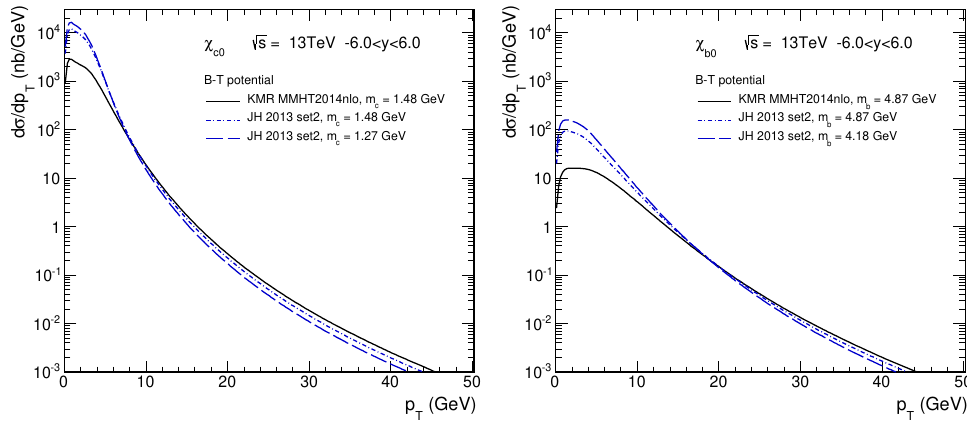
Figure 9 . Comparison of p T distributions of (cid:31) c 0 (left) and (cid:31) b 0 (right) for two di(cid:11)erent UGDFs. Here the Buchm(cid:127)uller-Tye potential was used.